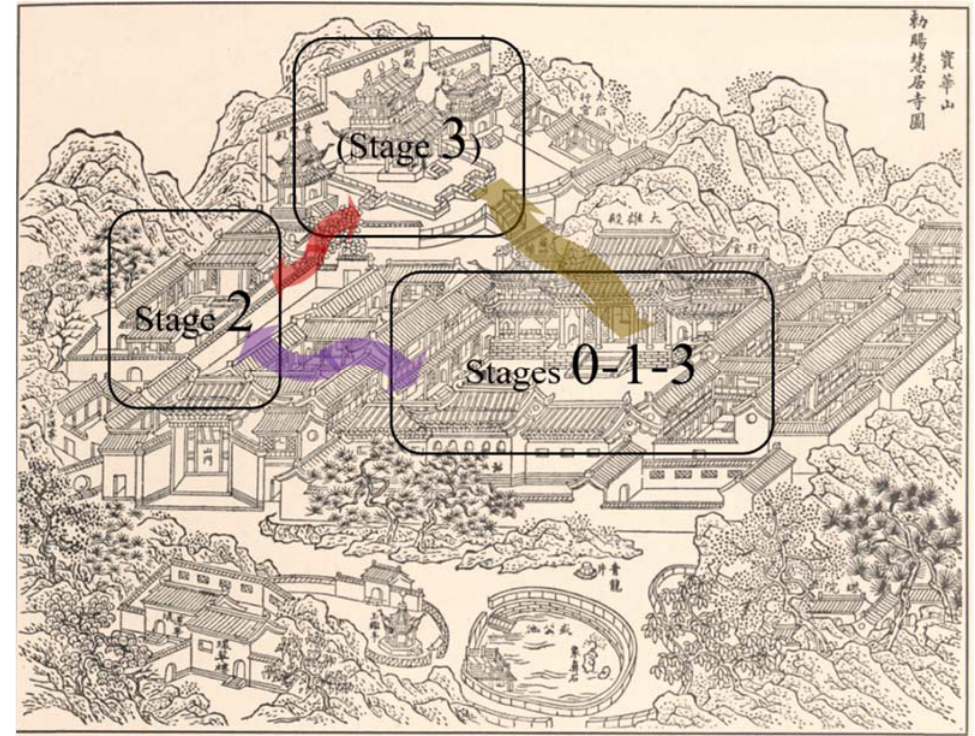
Figure 19. A diagram showing a coherent spatial system in which the main courtyard, the Open-Air Platform Unit, and the Ordination Platform Unit are associated with the prelude and the three stages of the threefold ordination rituals (Drawing by author, base map: Figure 1).